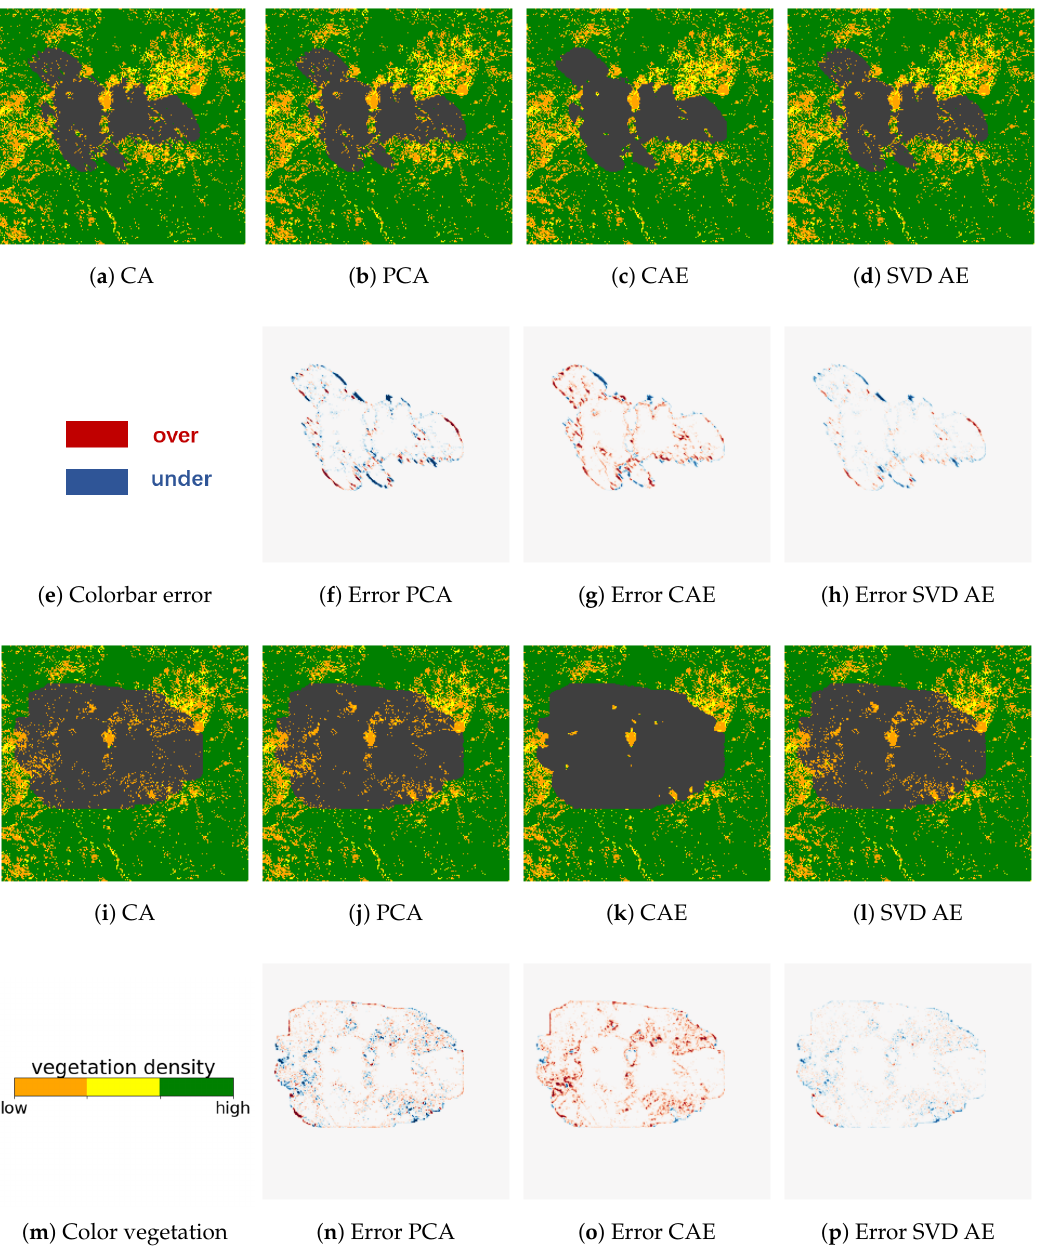
Figure 6. Reconstruction of CA simulations for 2 examples in the test dataset of the Ferguson fire at day